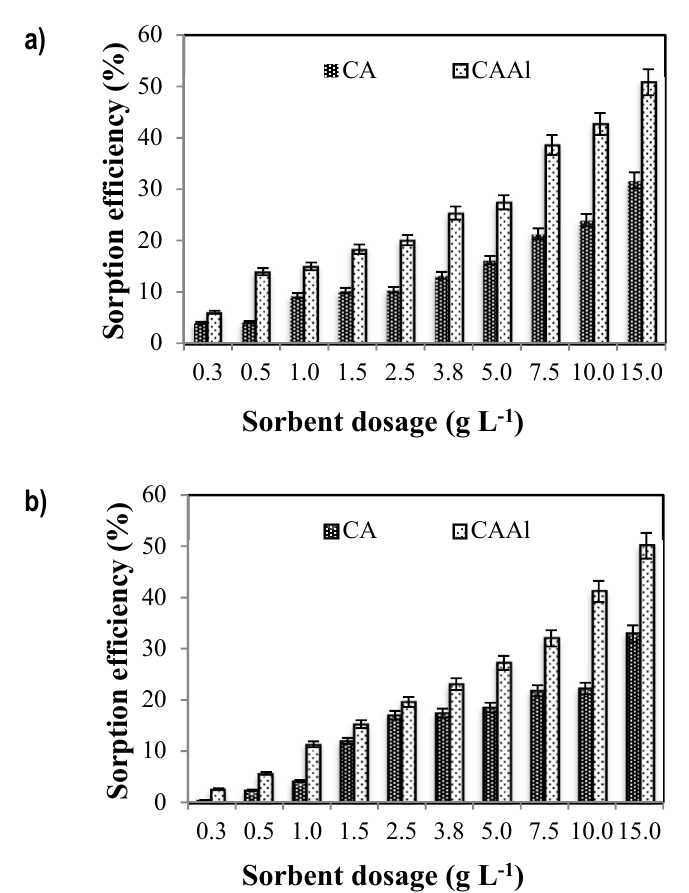
Figure 3. Effect of sorbent dosage on boron removal. ( a ) Removal performances using an initial boron concentration of 5 mg L − 1 ( b ) Removal performances using an initial boron concentration of 25 mg L − 1